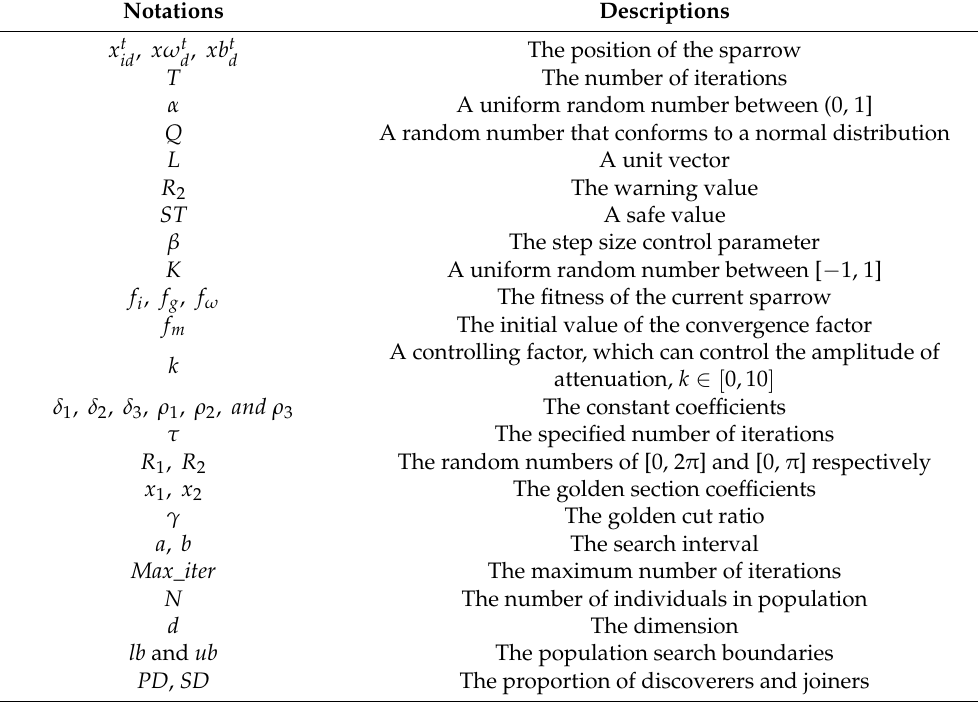
Table 1. Notation